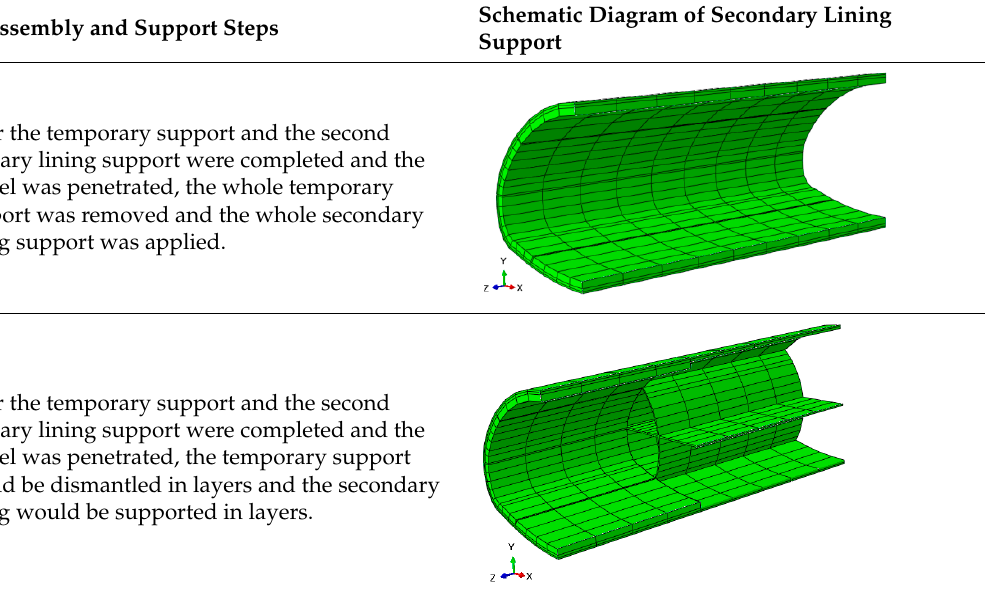
Table 6. The temporary support disassembly and second lining support working conditions.